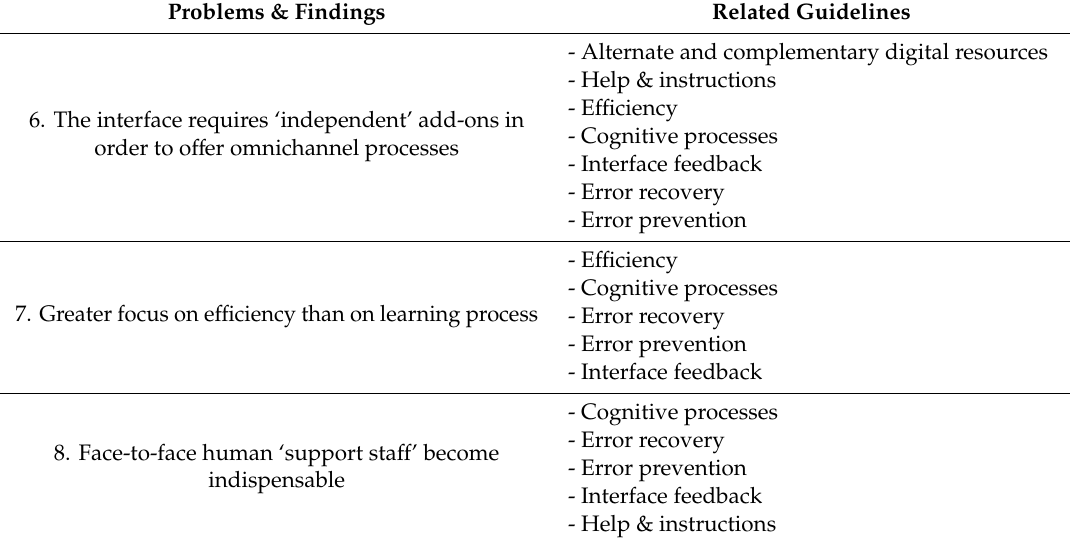
( b ) Figure 20. Left image ( a ) kiosk vending machine for the Metrobús in Mexico City. Right image ( b ) taxi tickets at the Monterrey airport. Both have only been designed for people of average height. Furthermore, most interfaces do not have braille or support audio-based navigation for the blind, which is despite much of the hardware containing the technology that would be required to do so. Any audio technology that was encountered served only to request assistance for resolving a problem with payment or a technical glitch with the interface itself. See Figure 21 for details.